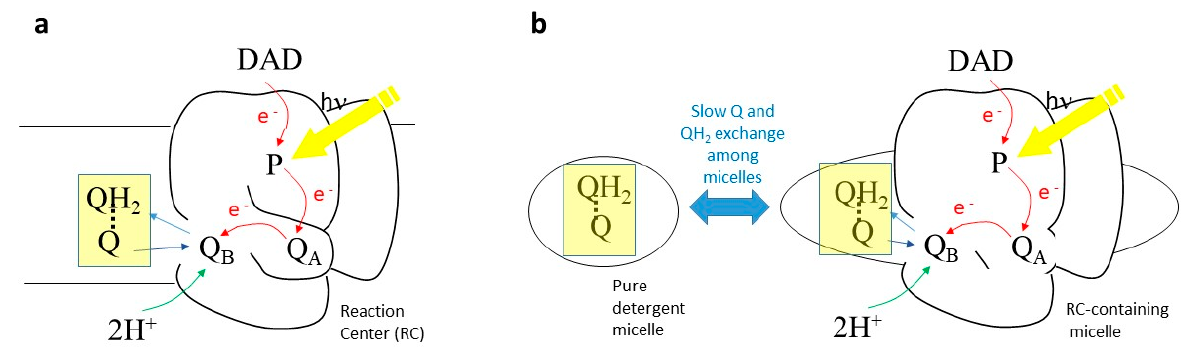
Figure 9. Conditions under which quinhydrone complex could form in chromatophores ( a ) or detergent-isolated RCs ( b ).